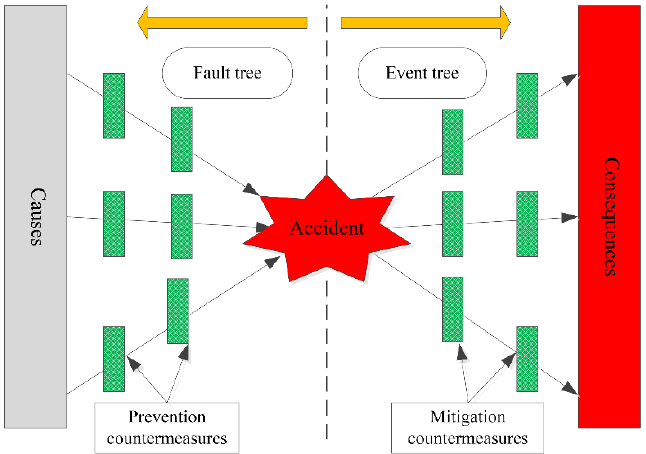
Figure 2. Flow chart of the bow-tie model. Figure 2 indicates the frame of the bow-tie model. For the causes and consequences